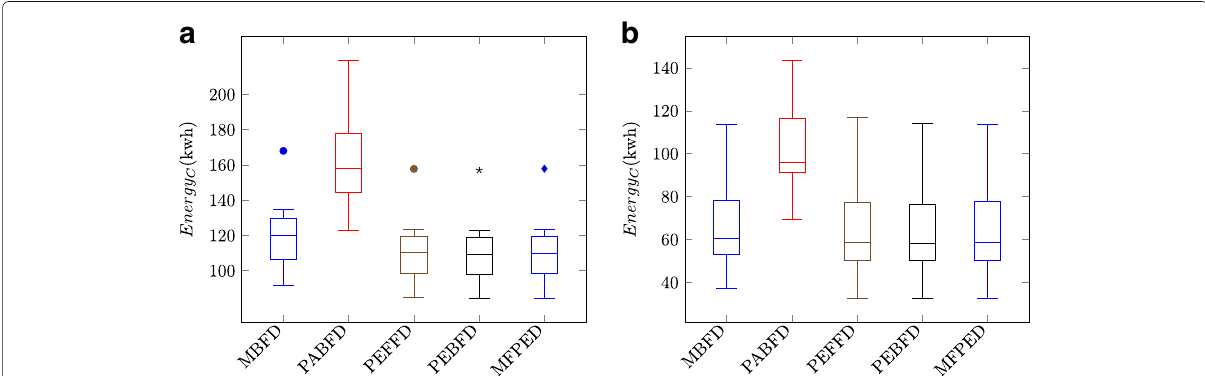
Fig. 2 Comparison by energy efficiency of algorithms in the Default-scenario. Total energy consumption in data-center with two types of dual-core HP ProLiant servers. MBFD and PABFD are the baseline algorithms and the rest are the proposed ones. a Results using PlanetLab traces. b Results using Bitbrains